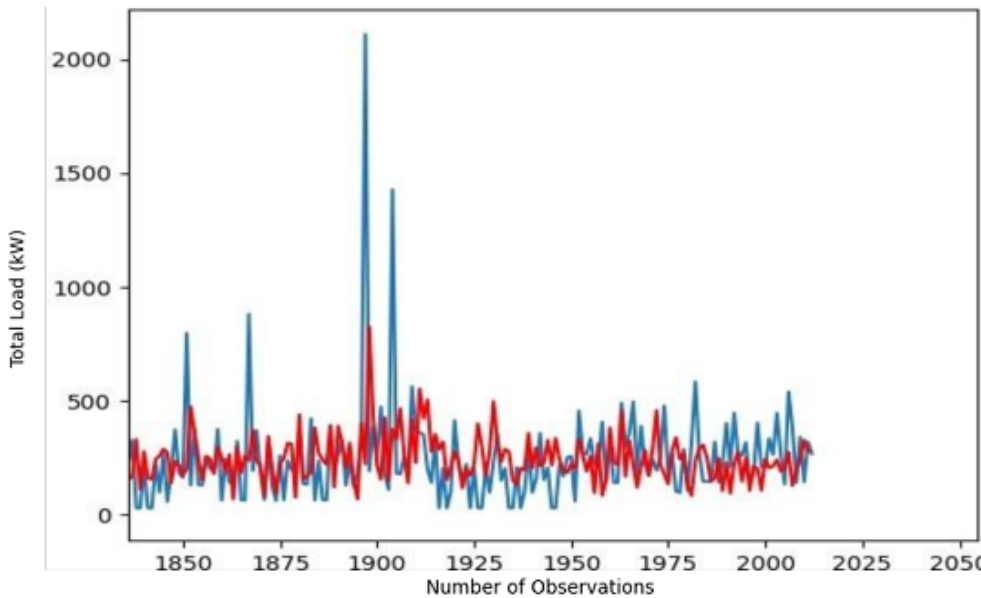
Figure 9. Actual and forecasted load (household). The actual load is depicted with red color and the forecasted time series with blue color.